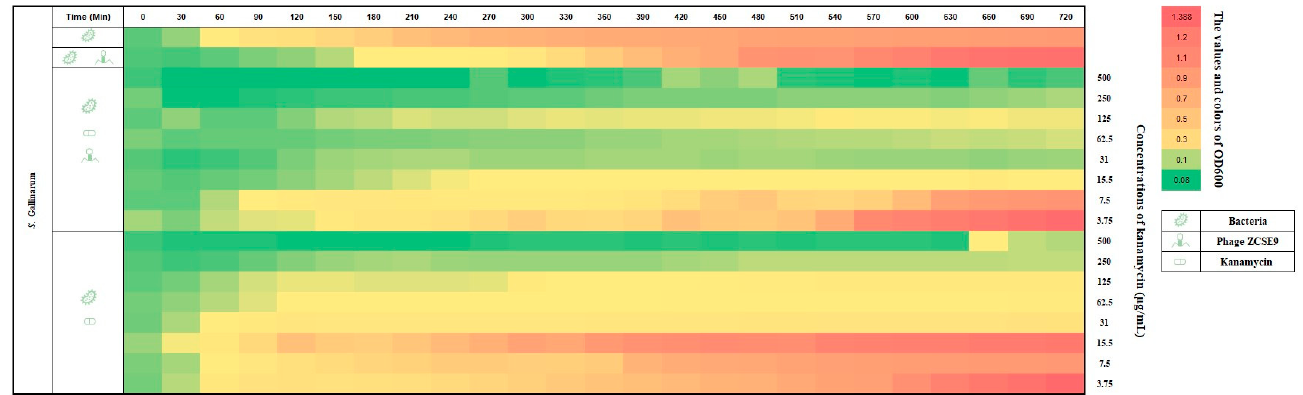
Figure 11. Heat plot corresponding to the synergy of phage ZCSE9 and kanamycin against S. Gallinarum (CMPZC49G.B). The bacterial growth at OD 600 was represented with colors and numbers in the right vertical bar; red is the highest growth, and green is the lowest.